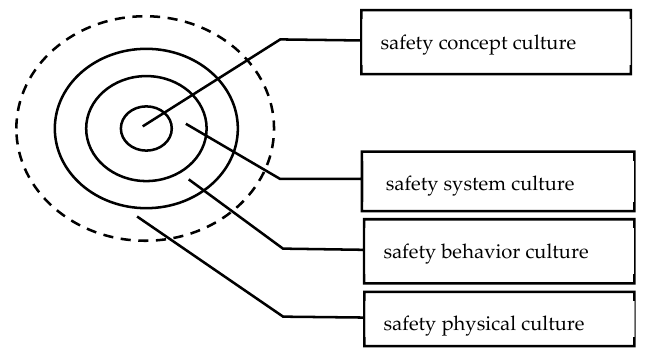
Figure 1. Hierarchy of Safety Culture—“Concentric Circle Theory”. Table 1. Index System of Safety Culture Maturity Model.